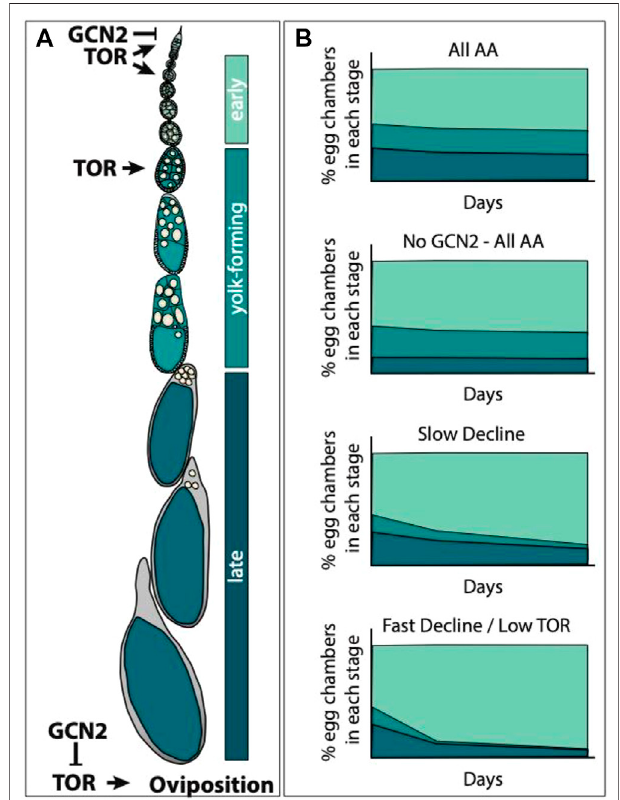
FIGURE 4 | Predicting how diets that induce a slow versus fast decline impactegglaying via theTORpathway. (A) Eggchamberdevelopmentcanbe broadly divided into three stages: 1) early stages (stages 1 – 7), yolk-forming stages (stages 8 – 10), and late stages (stages 11 – 14). TOR signalling promotes germline stem cell maintenance, egg chamber growth, and the transitionintoyolk-formingstages(LaFeveretal.,2010).BothTORandGCN2 regulate oviposition; TOR signalling promotes oviposition while GCN2 signalling inhibits TOR to suppress oviposition (Armstrong et al., 2014). (B) GCN2 mutant females (No GCN2 — All AA) should have normal stem cell numbers and should not show repression of oviposition. Relative to wild type females on diets containing all amino acids (All AA), this might result in faster rates of oviposition, reducing the percentage of late stage egg chambers. We would expect ovaries from females on amino acid drop out diets (Slow and Fast Decline) to have reduced percentages of egg chambers in the yolk- forming and late stages relative to ovaries from females on All AA. If this difference is due to differences in the sensitivity of the TOR pathway across amino acids, then we would predict that on the slow decline diets we would see a more gradual decline in the percentage of yolk-forming egg chambers than on the diets that induce fast decline in egg laying. Treatment with rapamycin(lowTOR)shouldreduce oreliminatethedifferences betweenslow and fast decline